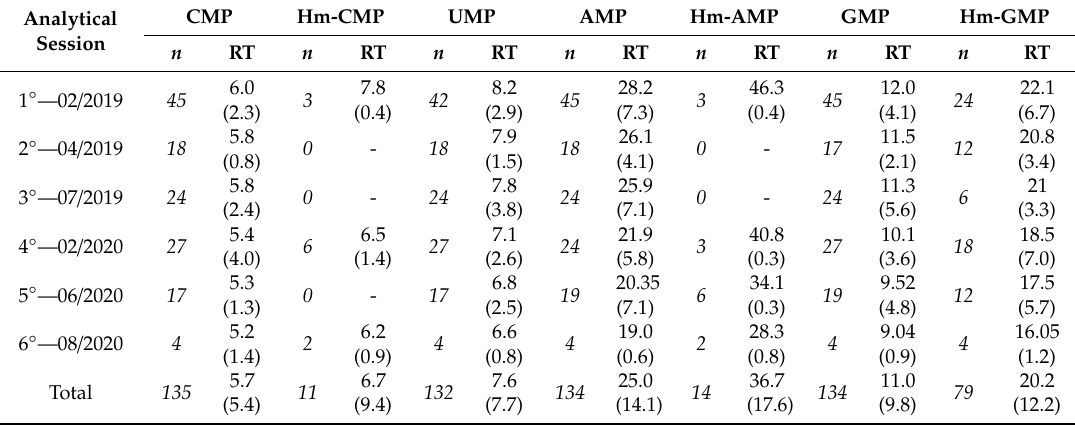
Table 2. Retention times (RT) for each NMP and hm-NMP detected in the analytical sessions; n represents the number of detections, RT represents the retention time in minutes, in brackets are reported the coe ffi cients of variation